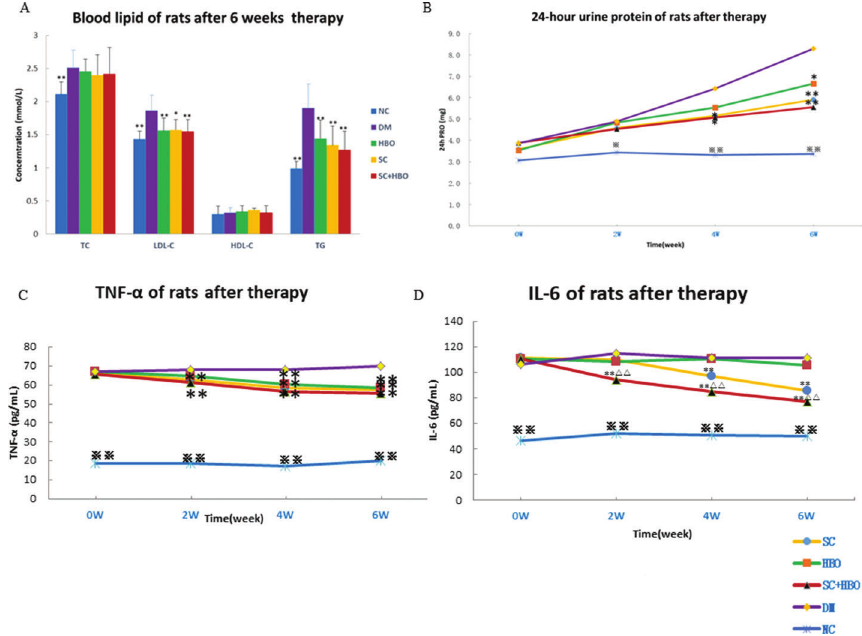
Figure 2 - Blood lipid, proinflammatory cytokine, and urine protein of rats. A. Blood lipid after 6 weeks of therapy: Serum TG and LDL levels were higher in SC + HBO, SC, and HBO groups than those in the DM group. B. 24h urine protein: After 4 weeks, urine protein levels began to decrease in SC + HBO and SC groups as compared with those in DM group. C. Serum TNF- a : After 2 weeks, serum TNF- a levels began to decrease in SC + HBO and SC groups as compared with those in the DM group. After 4 weeks, serum TNF- a level of the HBO group was lower than that of the DM group. D. Serum IL-6: After 2 weeks, serum IL-6 levels in the SC + HBO group were lower than those in DM and HBO groups. After 4 weeks, serum IL-6 levels in the SC group were lower than those in the DM group. * p o 0.05, ** p o 0.01 vs DM group; WW p o 0.05 vs HBO group. : p o 0.05, :: p o 0.01 vs each of the other four groups.